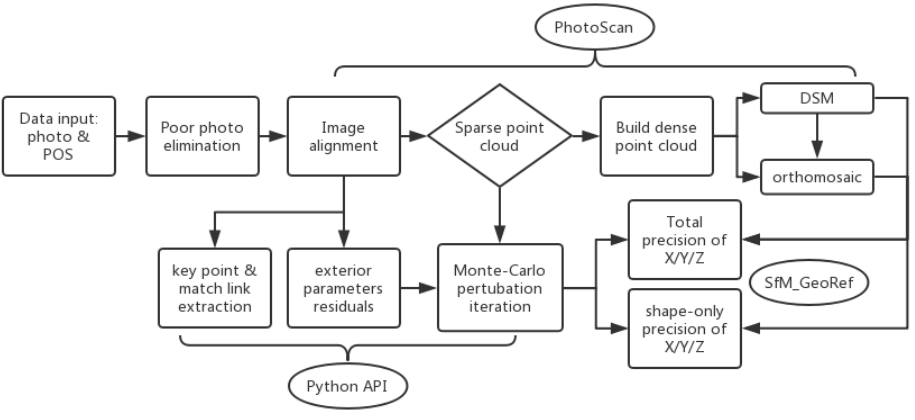
Figure 3. Flowchart of data